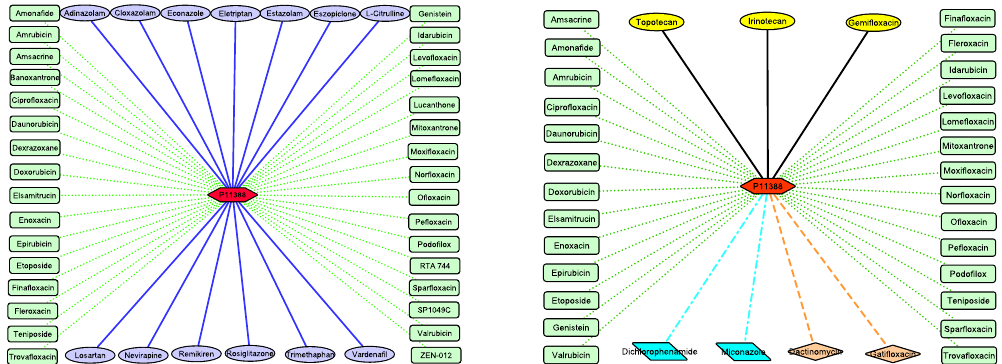
Figure 9. New drug repositioning candidates of P11388. Figure ( a ) describes the known DTIs and extracted NDTISs of P11388. Red hexagon denotes P11388, the green dotted lines denote known DTIs, the blue solid lines denote extracted NDTISs in ( a ). Figure ( b ) describes predicted DTIs of P11388. The green dotted lines denote successfully predicted DTIs, the orange dash lines denote predicted DTIs that can be validated by the related databases, the azure dash dotted lines denote predicted DTIs which have been reported by ref. 26, the black solid lines denote the other predicted results in ( b